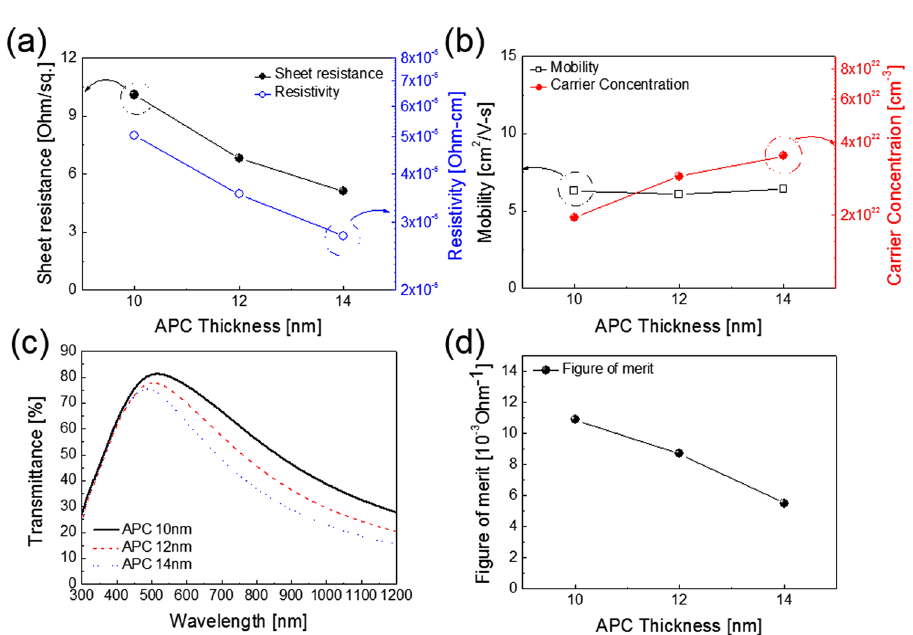
Figure 4. ( a ) Sheet resistance and resistivity and ( b ) mobility and carrier concentration of thermal evaporated SnO 2 /APC/SnO 2 multilayer film on a PET substrate as a function of APC interlayer thickness at a constant thickness of SnO 2 (20 nm). ( c ) Optical transmittance of the SnO 2 /APC/SnO 2 multilayer film with different APC interlayers. ( d ) FOM values of the SnO 2 /APC/SnO 2 multilayer film with different APC interlayer thicknesses.